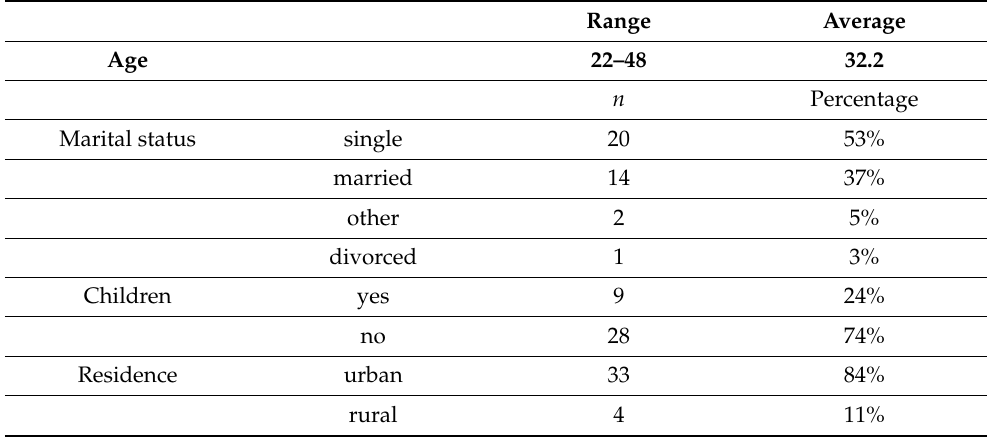
Table 1. Participant